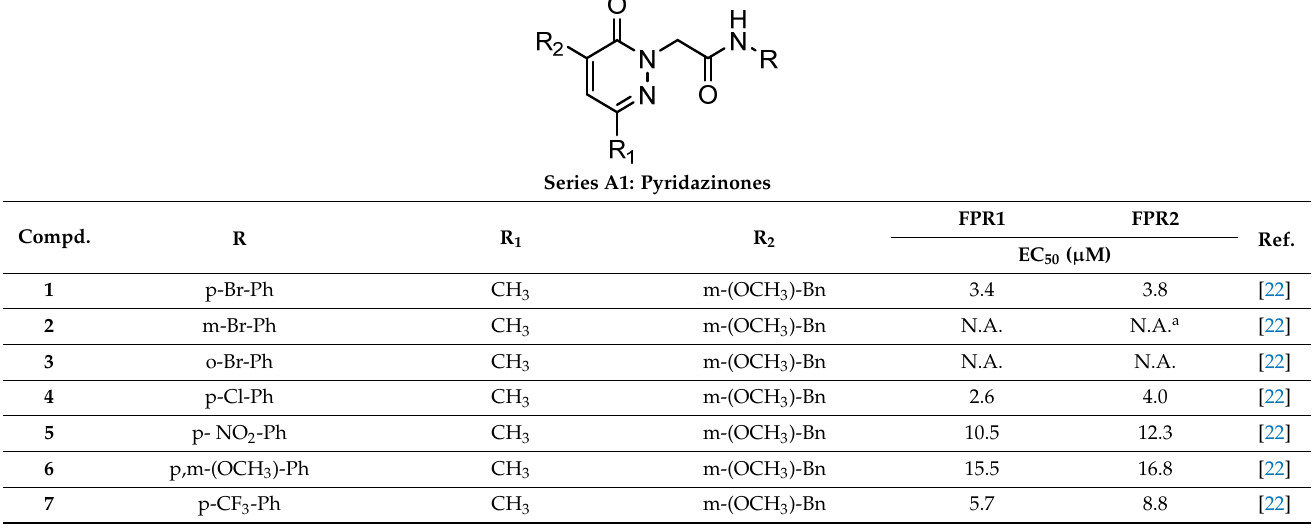
Table 1. Chemical structure and FPR1/FPR2 agonist activity of derivatives used for the evaluation of anti-inflammatory activity in human THP1-Blue cells.